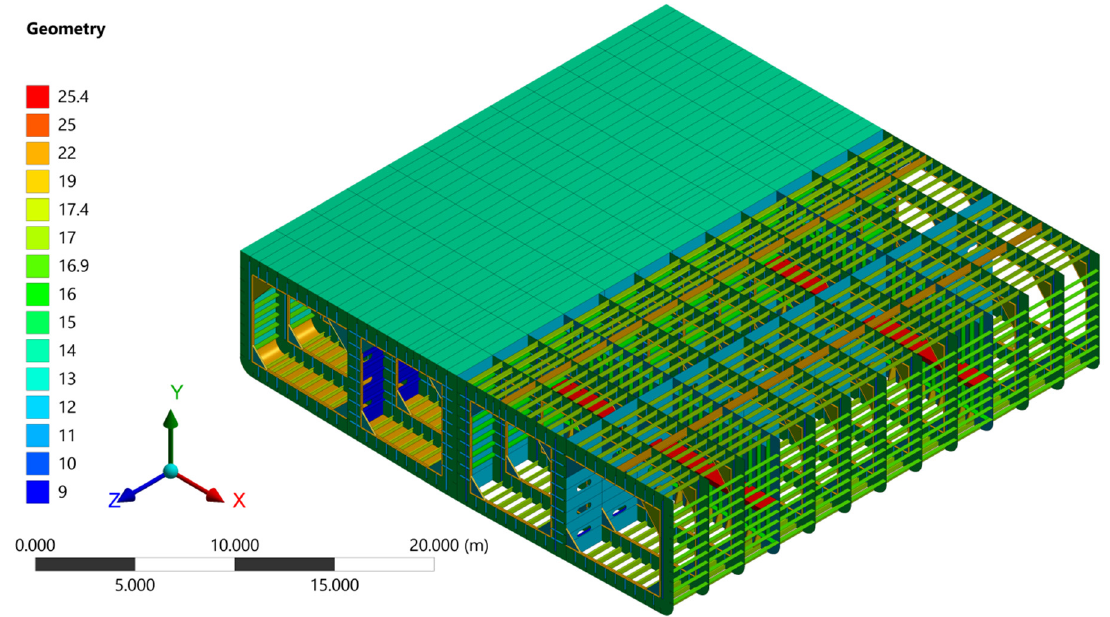
Figure 7. FEM model of the barge midship section, which include all its internal and external structural components. Note: the thicknesses (mm units) of these structural components are shown in the colorbar.